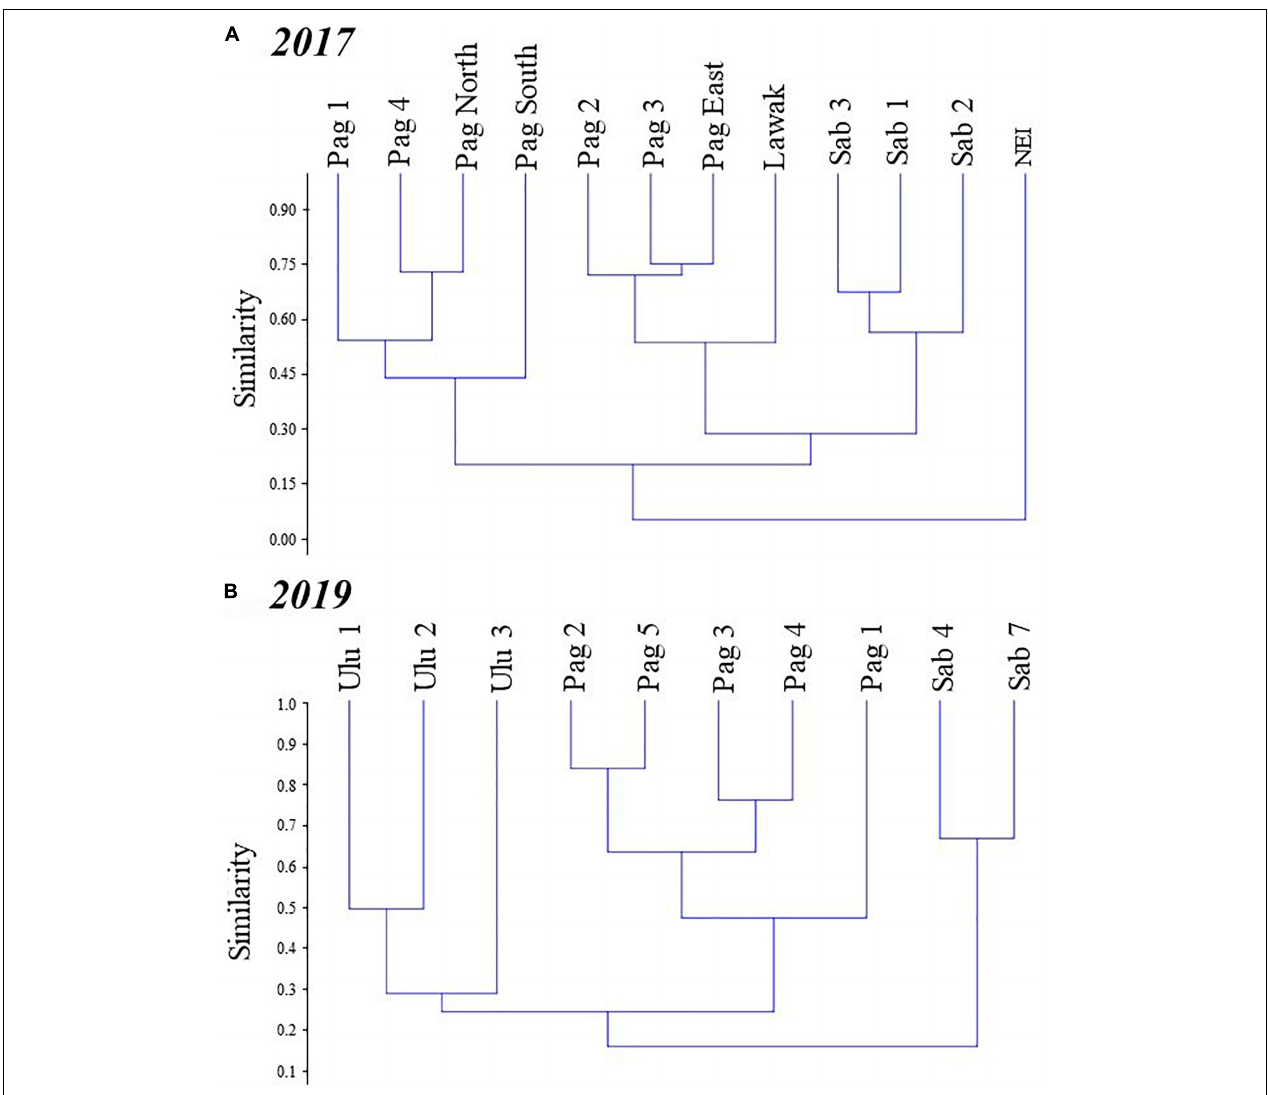
FIGURE 5 | Cluster analysis dendrogram based on the Bray-Curtis similarity index, showing differences in the octocoral assemblages in different stations in the Kalayaan Island Group [Pag-asa (Pag), Sabina (Sab), Lawak, and Northeast Investigator (NEI)] and Ulugan (Ulu), surveyed in (A) 2017 and (B)